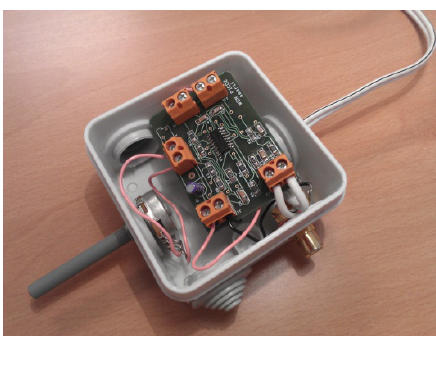
Figure 5. Signal conditioning and amplifying board